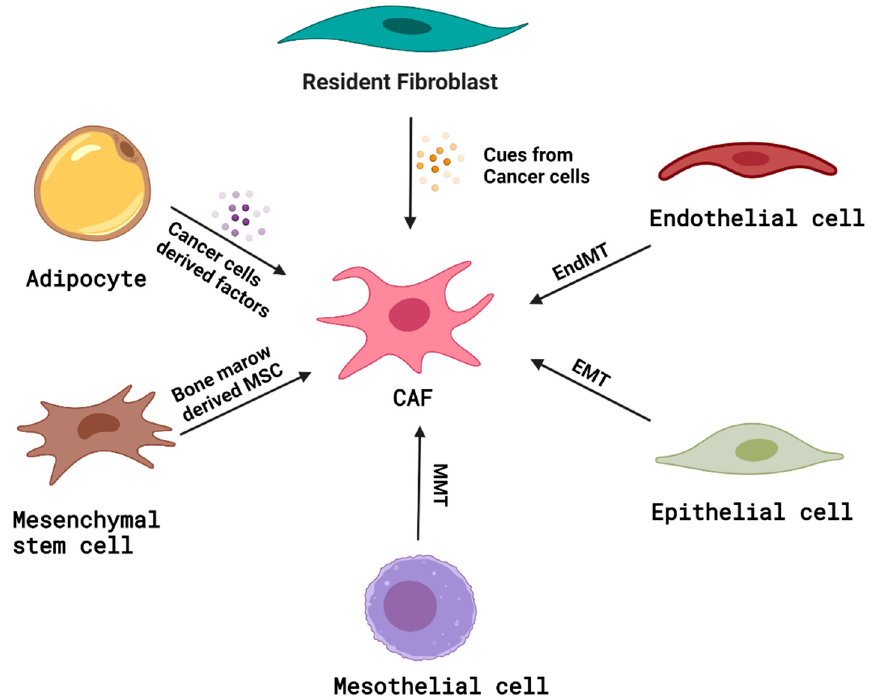
Figure 1. Origin of CAFs. Illustration of the potential cells of origin of CAFs, including resident fi- broblasts, endothelial cells, epithelial cells, mesothelial cells, mesenchymal stem cells, and adipocytes with probable mechanisms.